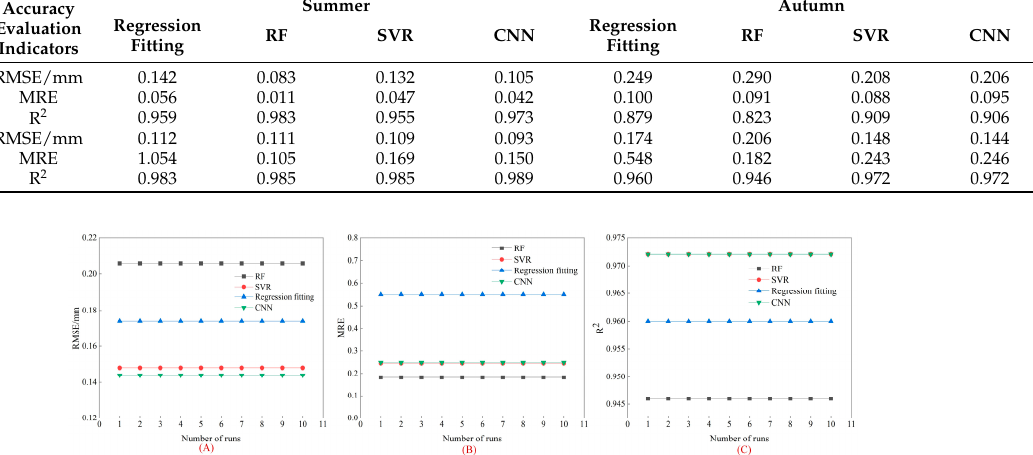
Figure 9. Model operation efficiency comparison based on autumn dataset: ( A ) RMSE; ( B ) MRE; ( C ) R 2 .